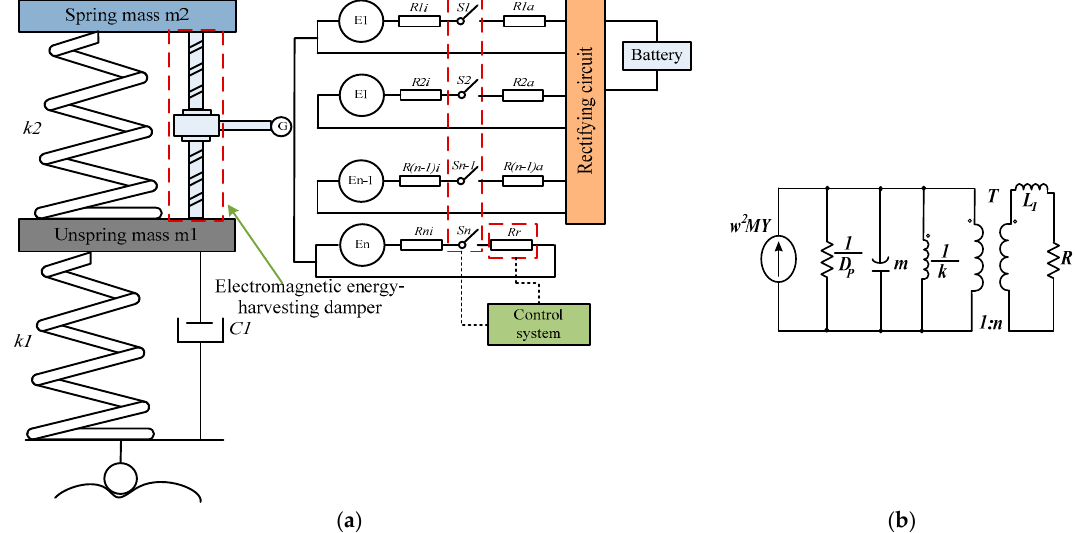
Figure 21. Block diagram of the spring, mass, damping method for EMEH system ( a , b ). Schematic of the spring, mass, damping system [93,121].